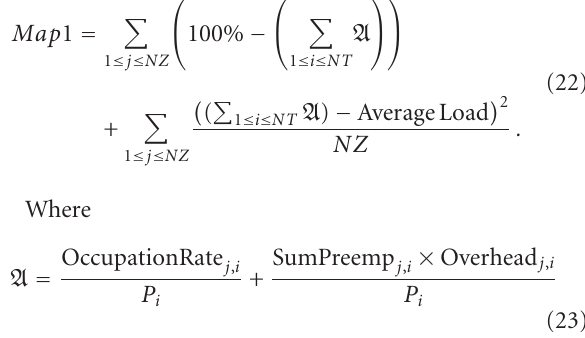
Algorithm 3. While in the task mapping subproblem,